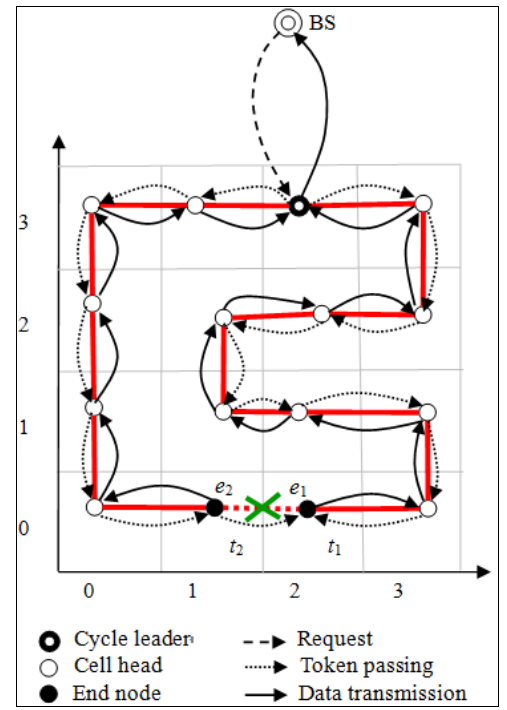
Figure 3. Scheme for data gathering in each